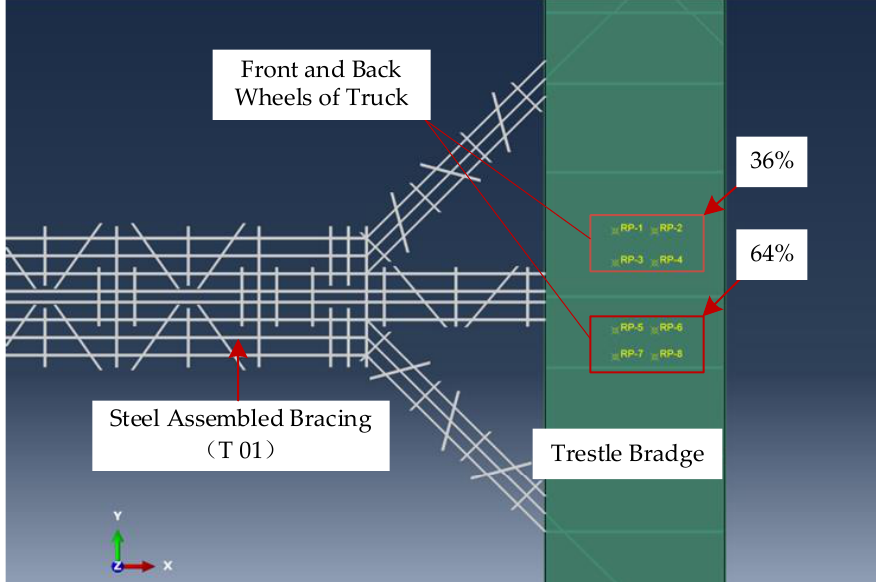
Figure 14. Maximum vibration response of trestle bridge during monitoring period.